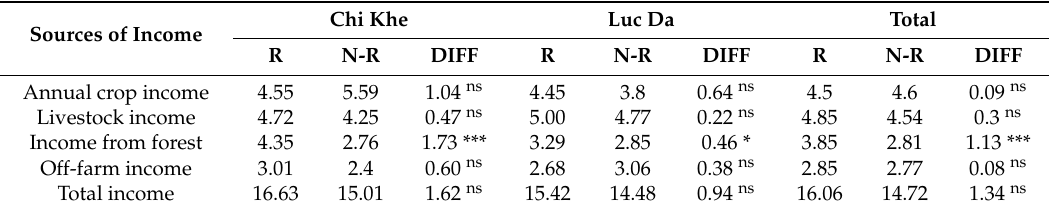
Table 6. Income sources of respondent households in Con Cuong District, Nghe An Province, 2016 (Unit: million